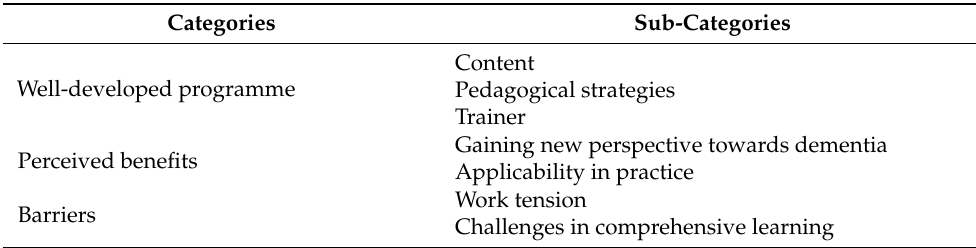
Table 3. Overview of categories and sub-categories of feasibility